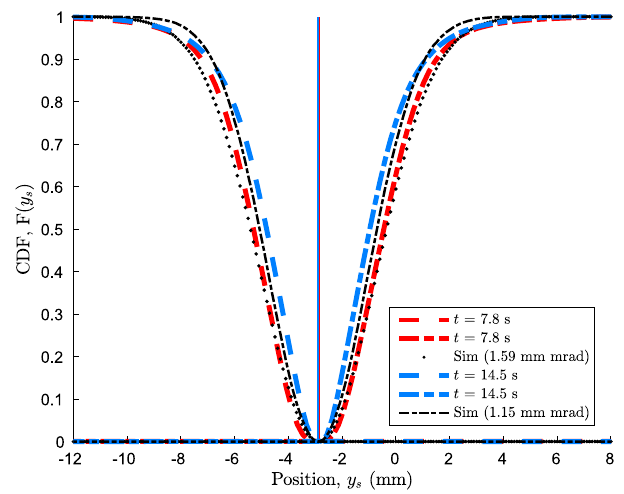
FIG. 4. Measured CDFs from vertical scraper scans are represented by colored dashed lines. Black dashed lines highlight corresponding simulations, while two (overlaying) vertical solid lines mark the calculated closed